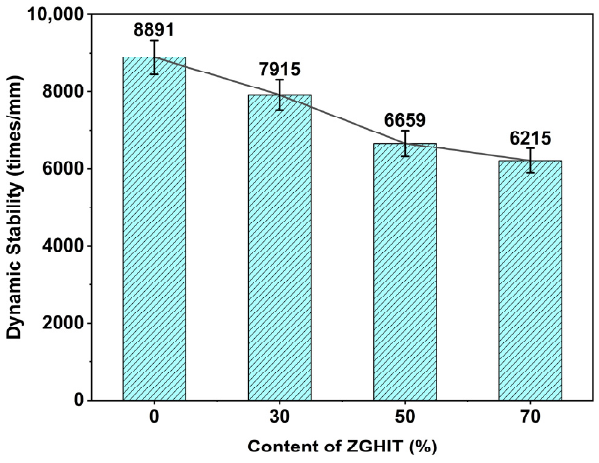
Figure 6. Results of wheel tracking test.